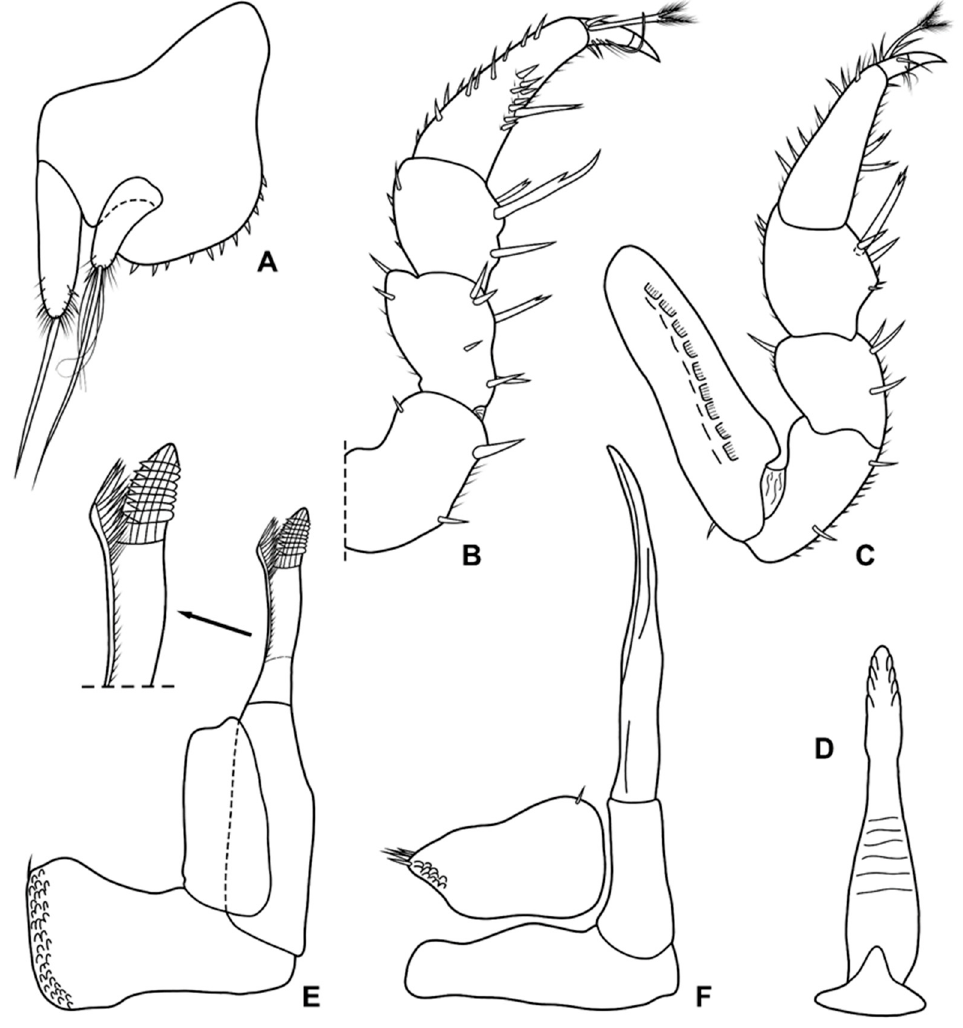
Figure 3. Buddelundiella zoiai sp. n., paratype ♂ from Murialdo. ( A ). Uropod. ( B ). Pereopod 1. ( C ). Pereopod 7. ( D ). Genital papilla. ( E ). Pleopod 1. ( F ). Pleopod 2.